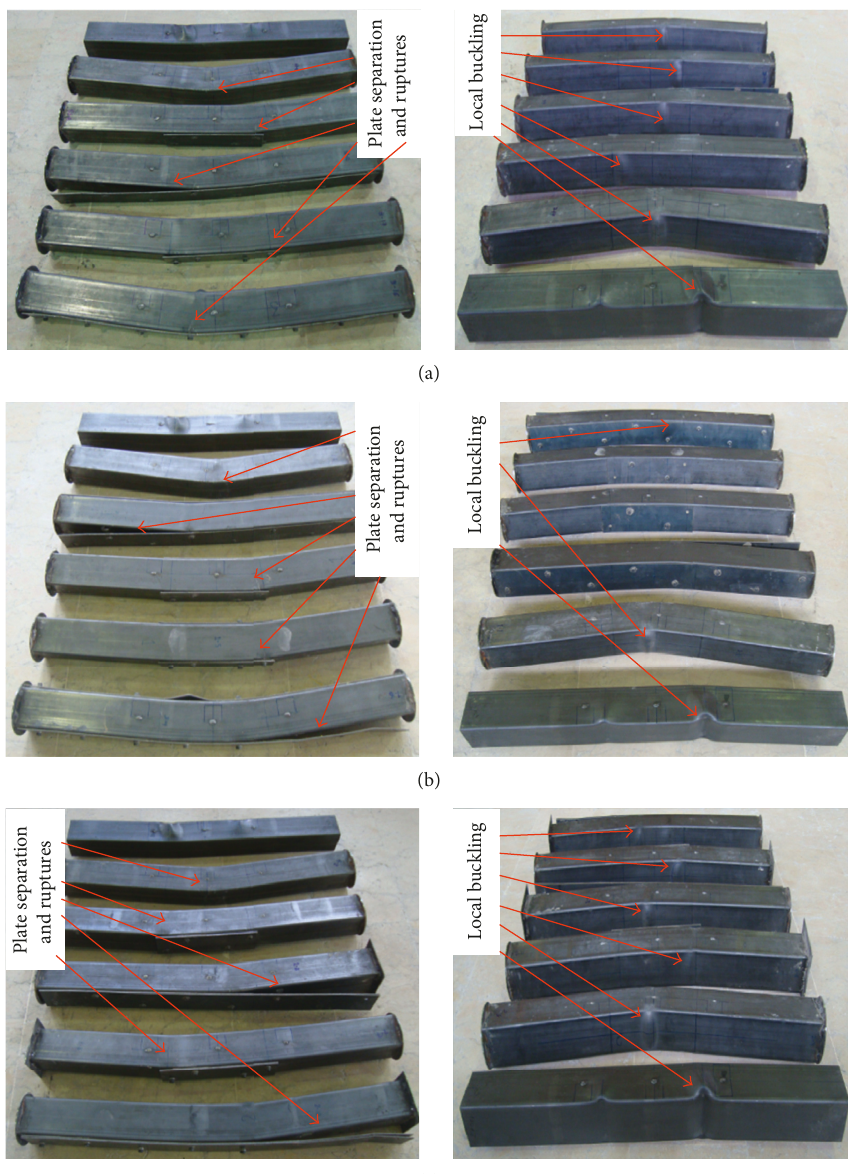
Figure 8: Failure modes of tested beams (general). (a) Group A retrofitting scheme (single bottom plate: SB). (b) Group B retrofitting scheme (top and bottom plates: TB). (c) Group C retrofitting scheme (double bottom plates: